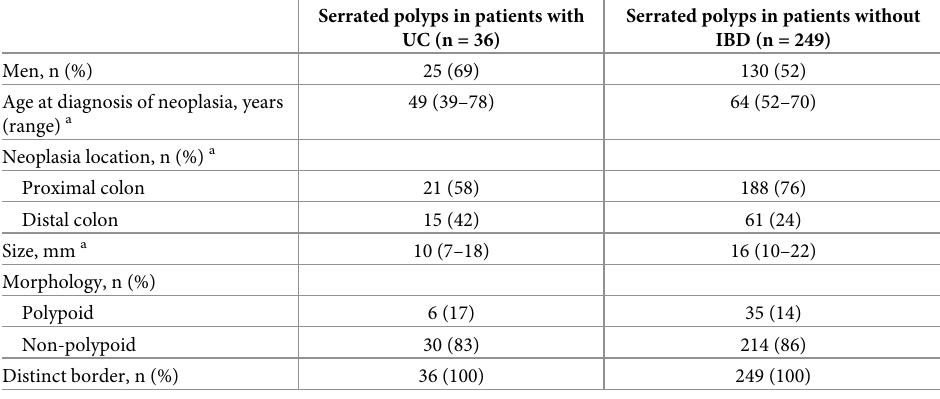
IBD, inflammatory bowel disease; UC, ulcerative colitis a P < 0.05 between serrated polyps in patients with UC and without